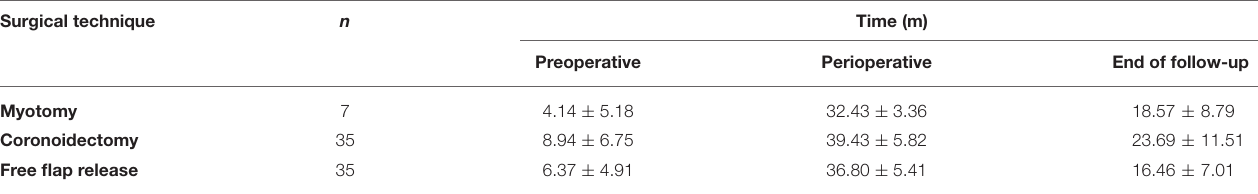
TABLE 3 | The mean maximal mouth opening and standard deviation (SD) for three surgical techniques and time points: preoperative, perioperative and at the end of follow-up. Surgical technique